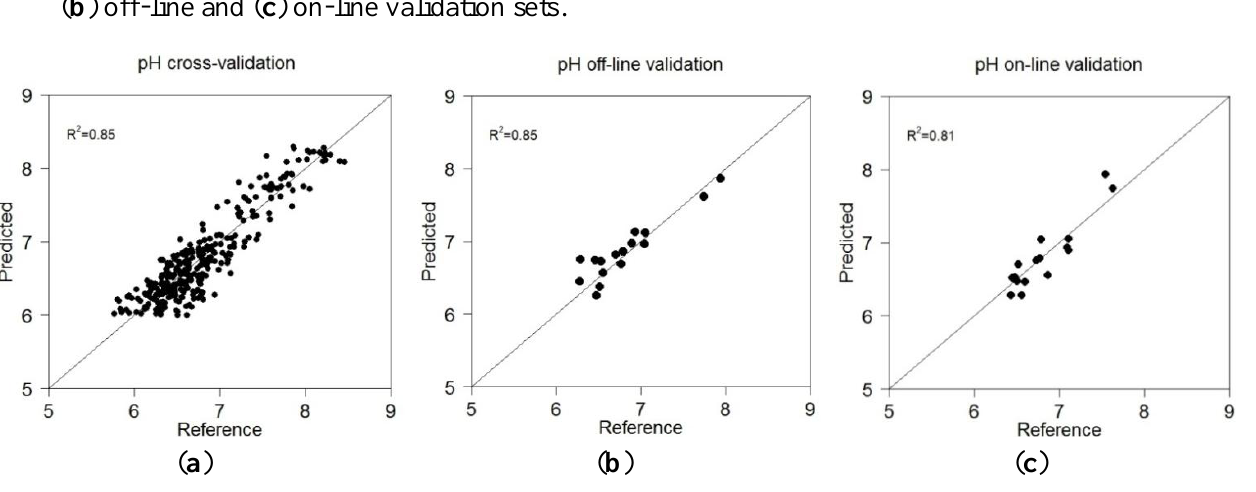
Figure 3. Scatter plot of predicted versus reference measured pH for ( a ) cross-validation, ( b ) off-line and ( c ) on-line validation sets.